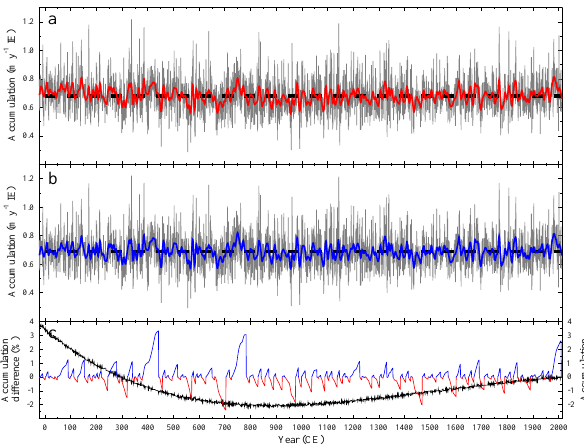
Figure 4. Annual (grey) and smoothed (coloured) snow accumula- tion rate history for 22BCE–2012CE based on (a) piece-wise linear vertical strain rate profile, with the long-term average snow accumu- lation rate of 0.680myr − 1 IE shown (dashed horizontal), (b) power law vertical strain rate profile, with the long-term average snow ac- cumulation rate of 0.686myr − 1 IE shown (dashed horizontal) and (c) difference in the smoothed accumulation histories (piece-wise linear-power-law vertical strain rate) normalised by the power-law vertical strain rate (black) and accumulation excess (Eq. 5) for pos- itive (blue) and negative (red)